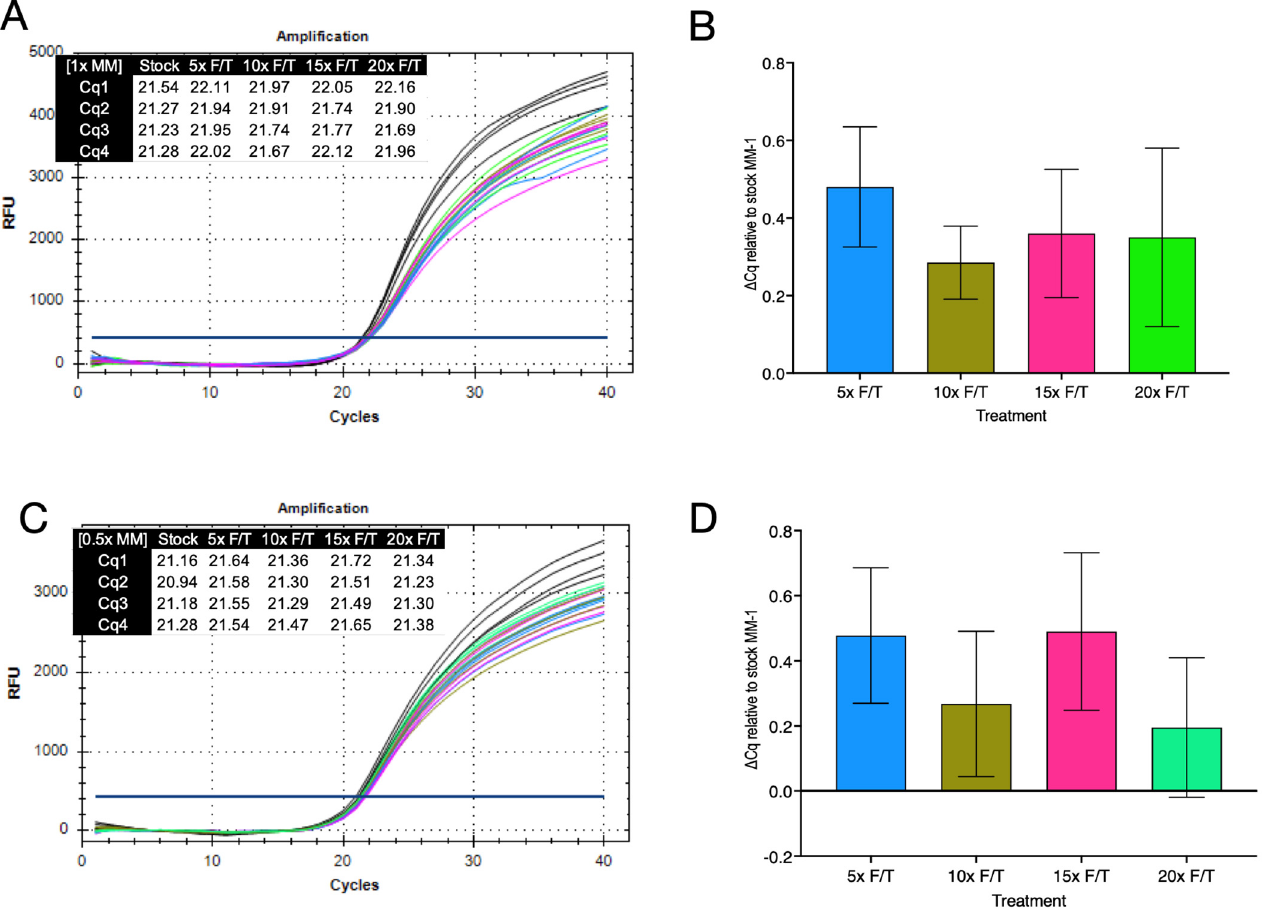
Figure 7. Analysis of the effect of repeated cycles of freezing and thawing (F/T) on MM-1. Original MM-1 stock (black), aliquots frozen and thawed 5 times (blue), 10 times (olive), 15 times (pink) and 20 times (green). ( A ). Amplification plots and Cq values for assay A amplified with 1× final concentrations of master mix. ( B ). ∆ Cq values relative to stock MM-1 of the various MM-1 aliquots amplified at 1× final concentration. ( C ). Amplification plots and Cq values for assay A amplified with 0.5× final concentrations of master mix. ( D ). ∆ Cq values relative to stock MM-1 of the various MM-1 aliquots amplified at 0.5× final concentration.